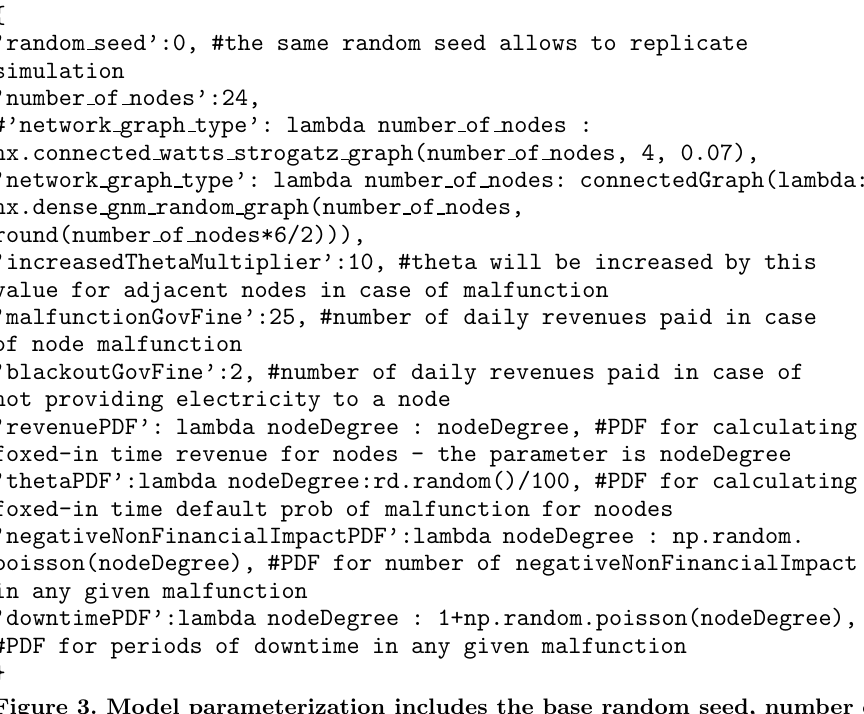
Figure 3. Model parameterization includes the base random seed, number of nodes, network structure, malfunction and downtime probability density